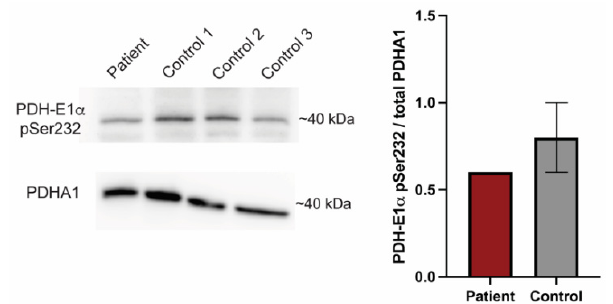
Figure 4. PDK1 G380D causes a reduction in phosphorylated PDH-E1 α . Phosphorylated PDH-E1 α (PDH-E1 α pSer232) is reduced in protein extracts from our patient fibroblasts when compared to three controls, which is consistent with the findings in zebrafish. The quantification was normalized to total PDHA1.